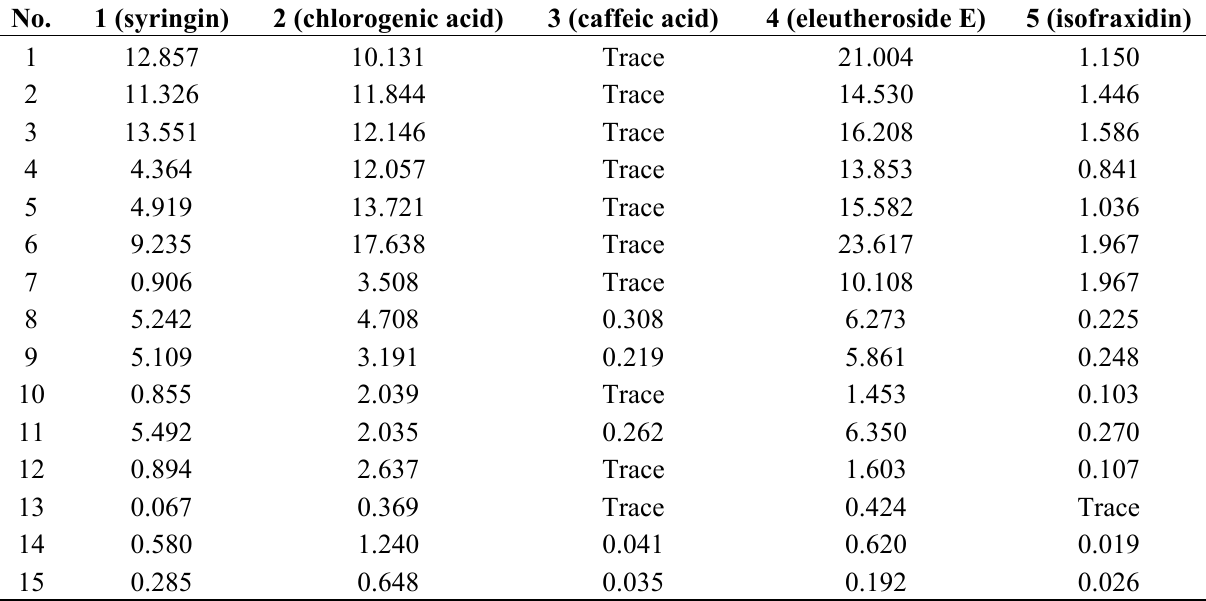
Table 3. The measurement results of compounds 1 – 5 in A. senticosus and its extract (mg/g).